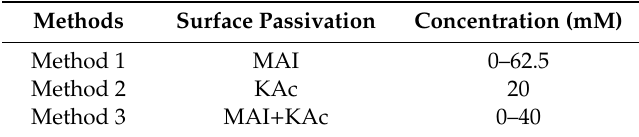
Table 1. Surface passivation methods for MAPbI 3 active